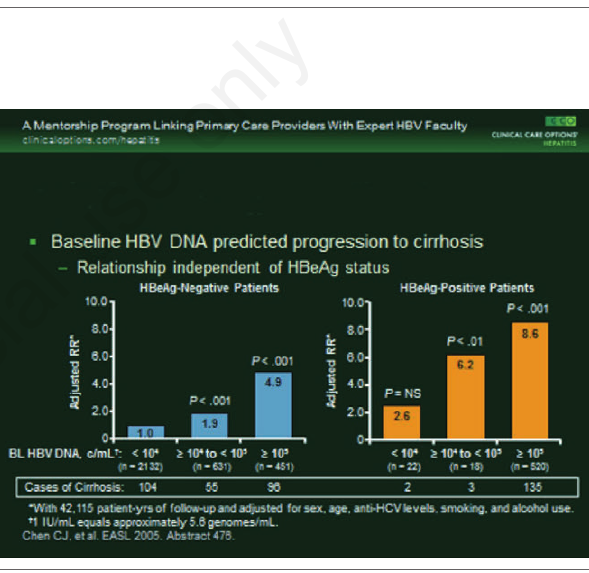
Figure 7. Cumulative incidence of cirrhosis by serum HBV DNA level at study entry.